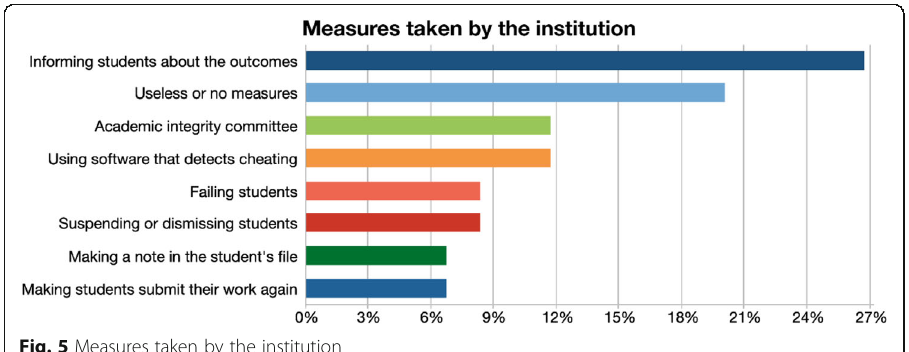
Fig. 5 Measures taken by the